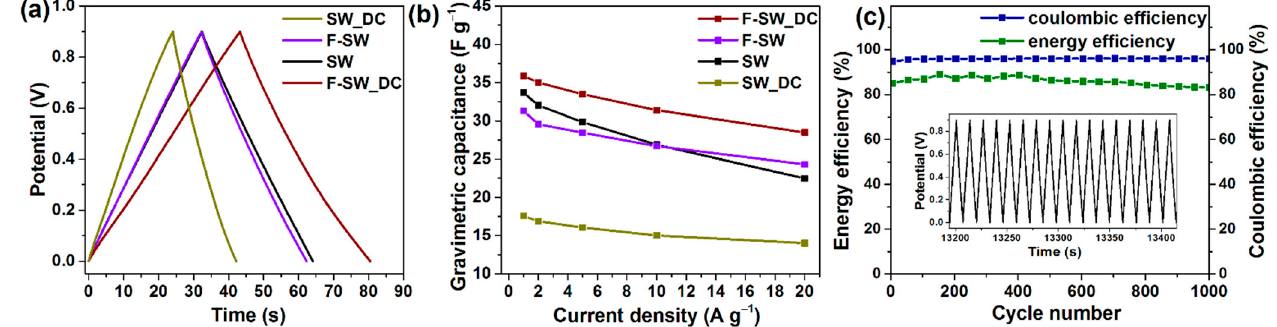
Figure 7. GCD curves of SWCNT-based films at the current density of 1 A g − 1 ( a ). Dependencies of gravimetric capacitance on current density ( b ). Energy and coulombic efficiencies of F-SW_DC electrode at 5 A g − 1 ( c ). Inset shows the GCD curves for last 17 cycles.